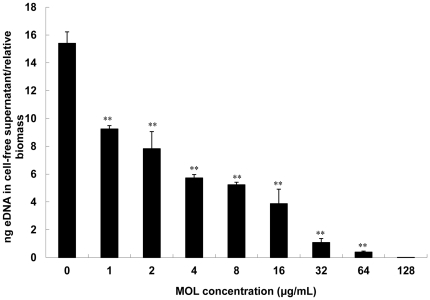
Role of MOL on DNA release of S. aureus.The amount of eDNA in the cell-free supernatants from the S. aureus strain ATCC 25923 biofilms treated with MOL at concentration of 1/16∼8× MIC was measured by spectrophotometry. The values are expressed as nanogram of eDNA per relative biofilm biomass (OD600). Values represent the mean ± SD for three independent experiments. ** represents p<0.01.